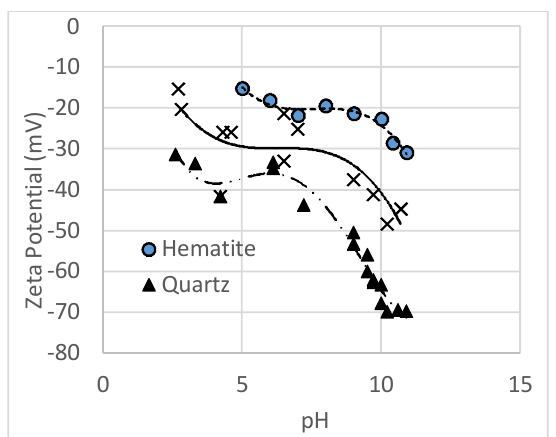
Fig. 3: ZP of Hematite, Quartz, and Kaolinite in Absence of POMI as a function of pH